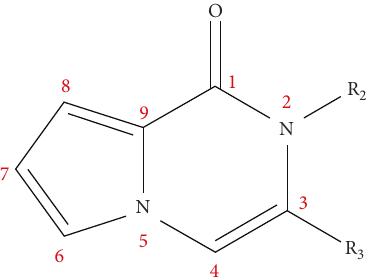
Scheme 1: Schematic representation of the structure and atom numbering of pyrrolopyrazinone derivatives (2 – 22) where R =CH , CH Cl, or CHCl ; R =H, Cl, CH , (CH 2 3 2 2 3 3 (CH ) CH Cl, (CH ) NH , NH , and (CH ) NHC(NH)NH 2 n 2 2 n 2 2 2 3